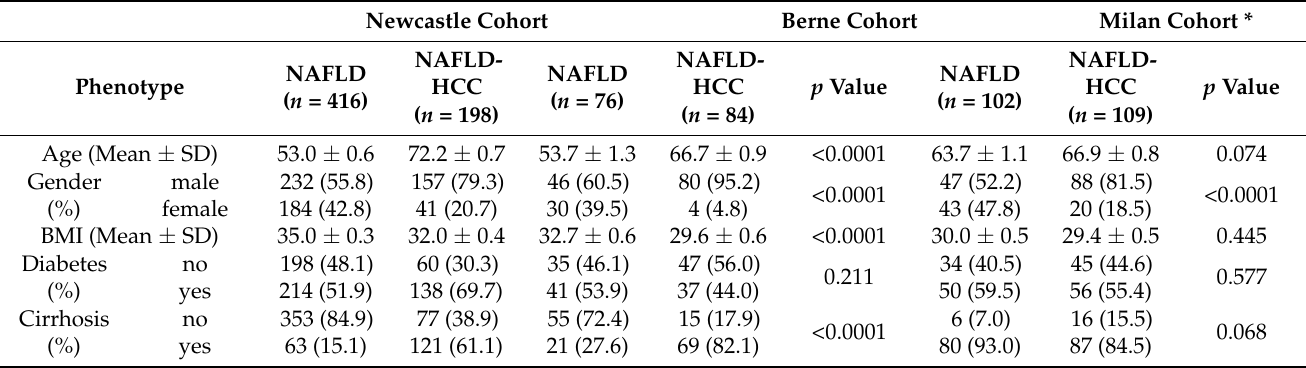
Table 4. Demographic characteristics of Berne and Milan NAFLD and NAFLD-HCC cohorts. Newcastle Cohort Berne Cohort Milan Cohort